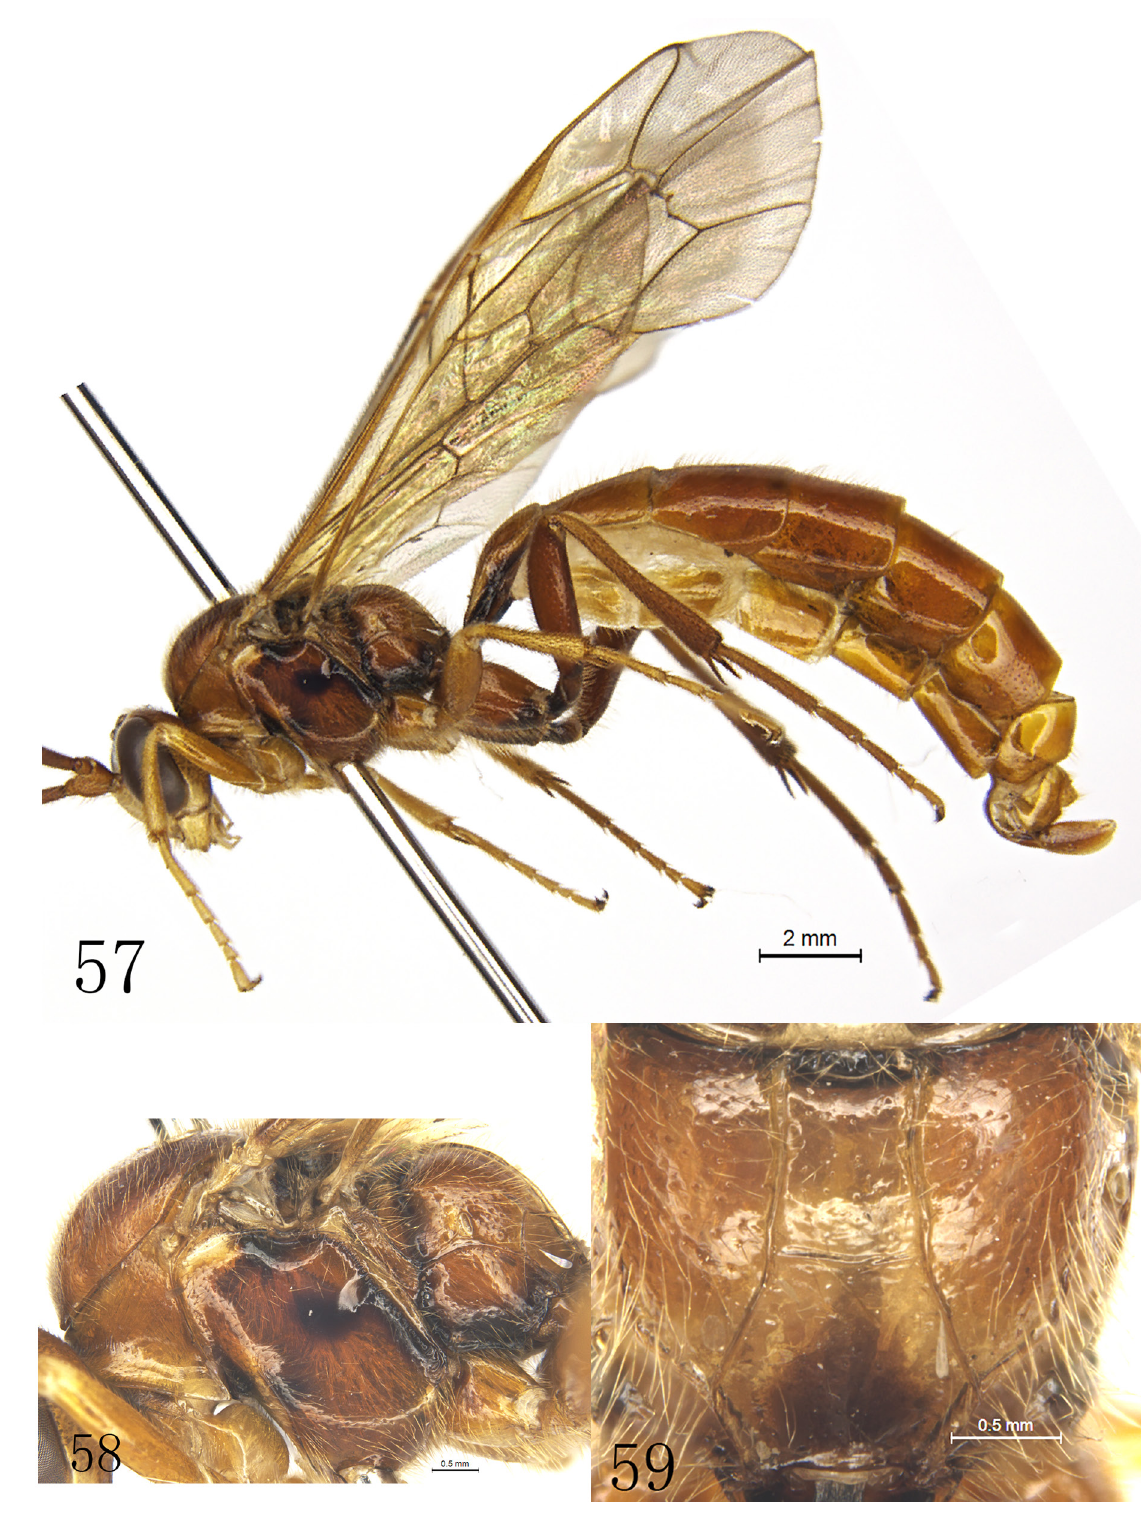
Figs 57–59. Ctenopelma rufescentis Sheng, 2009, holotype, ♀ (GSFGPM). 57. Habitus, lateral view. 58. Mesosoma, lateral view. 59.